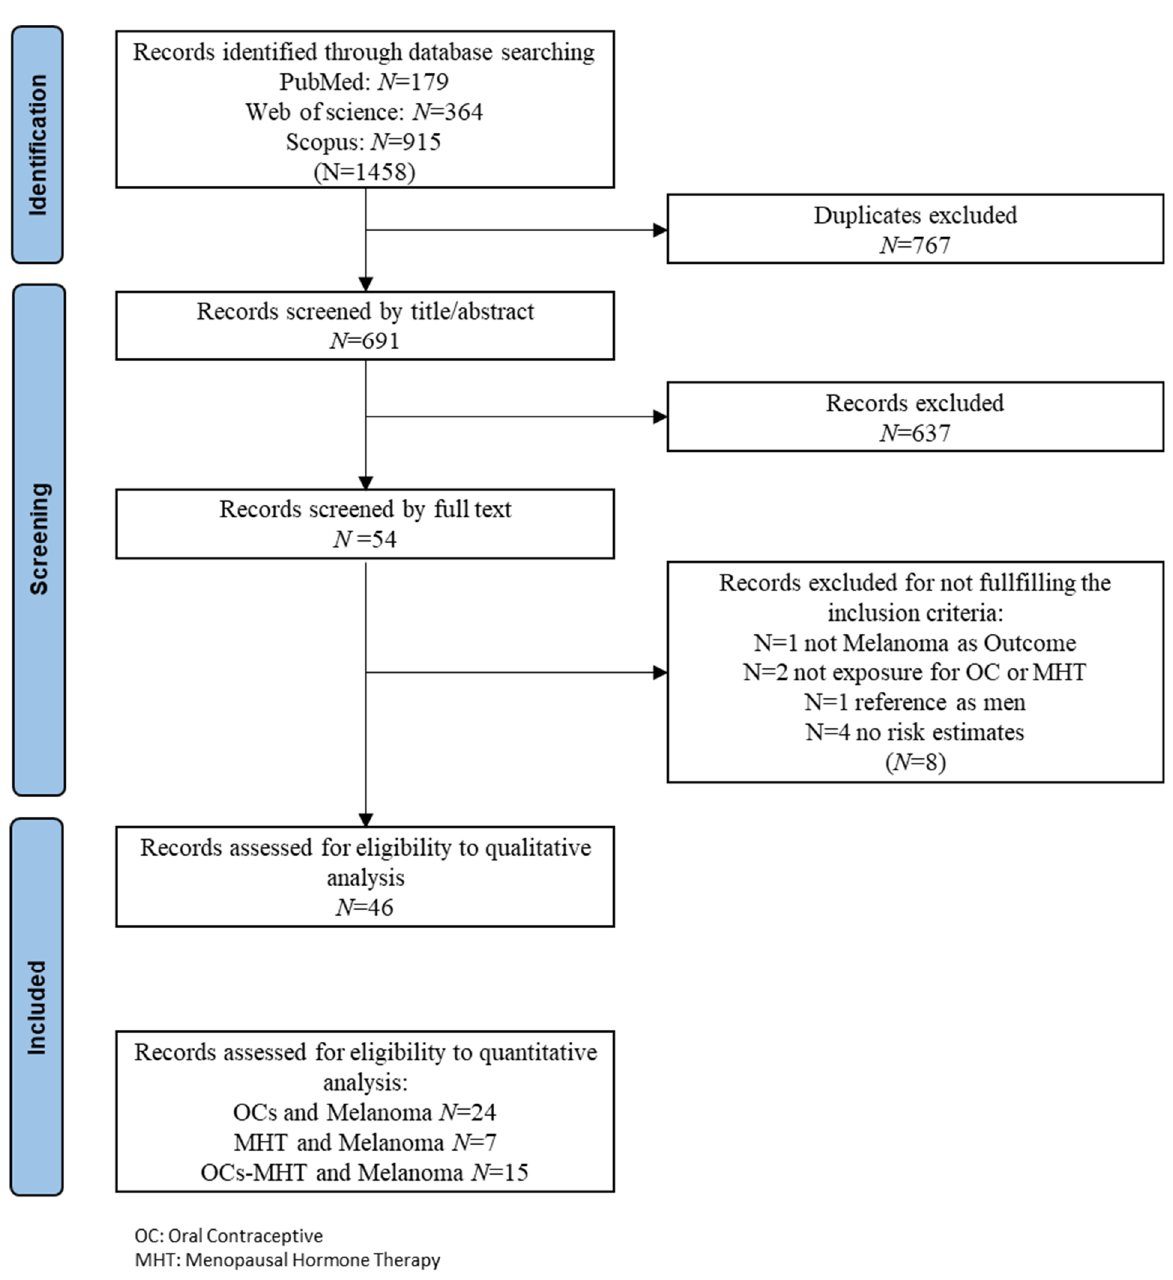
Figure 1. PRISMA flow chart of included studies.